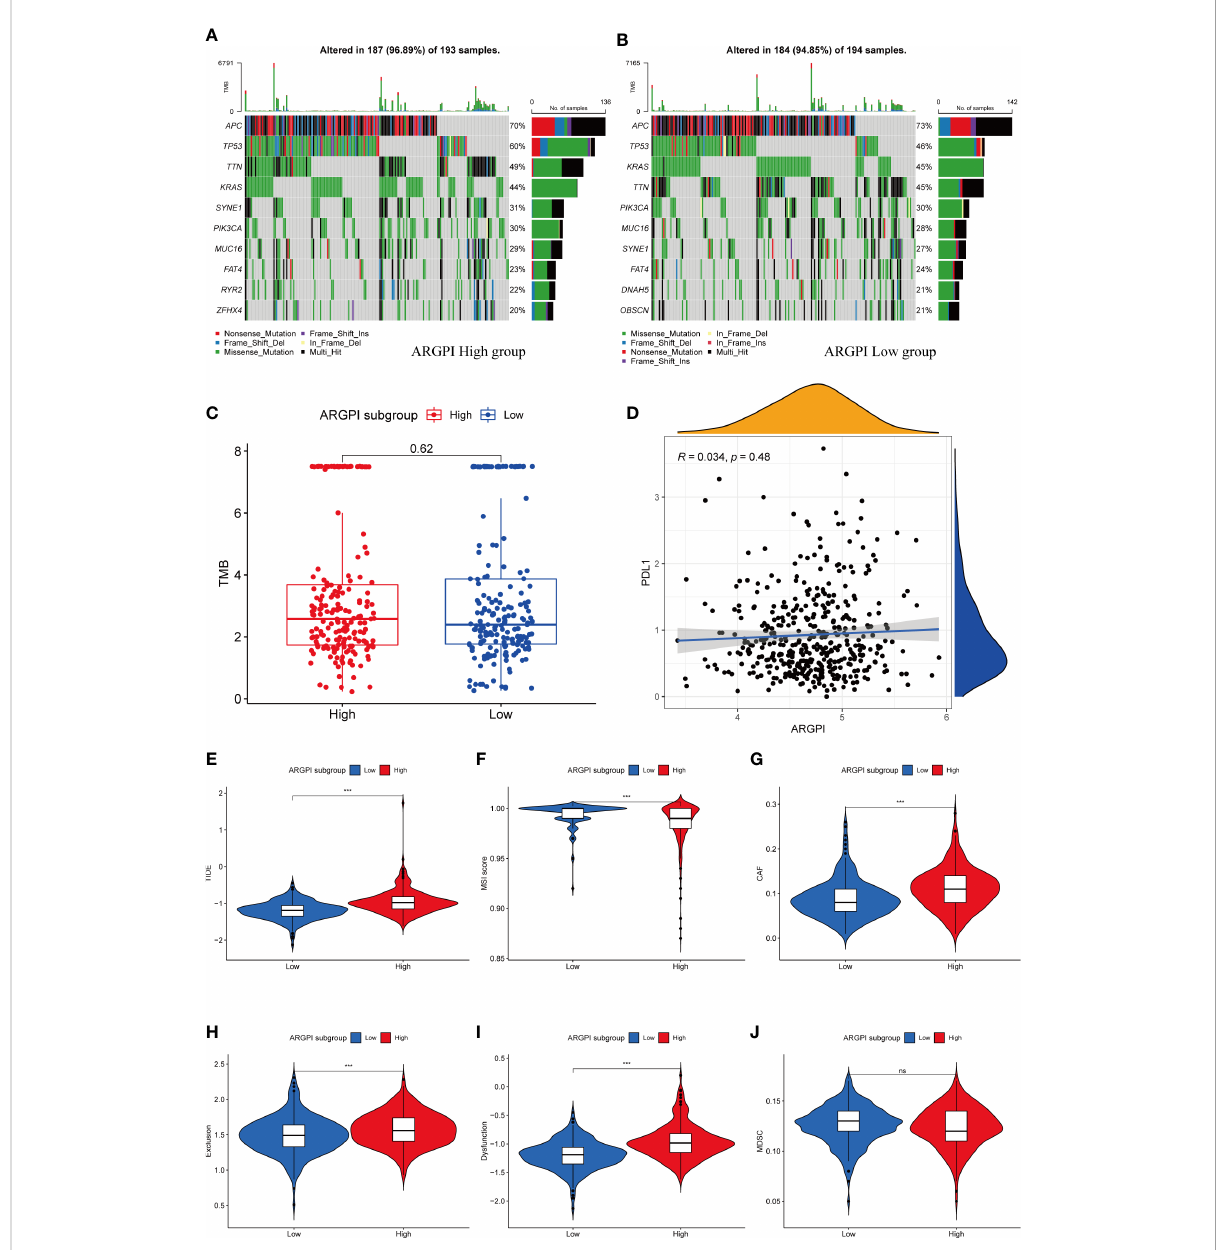
FIGURE 7 Association of ARGPI with markers for predicting ICI response. (A, B) The 10 most mutated genes in TCGA-COAD samples in the high and low ARGPI groups. (C) Differences in TMB in different ARGPI groups. (D) Correlation between ARGPI and PDL1 expression. (E – J) TIDE, MSI score, CAF, T-cell Exclusion and dysfunction scores, and MDSC in different ARGPI groups. “ ns ” represents not signi fi cant and “ *** ” represents p <